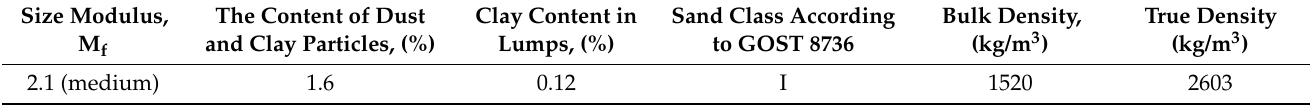
Table 3. Physical properties of